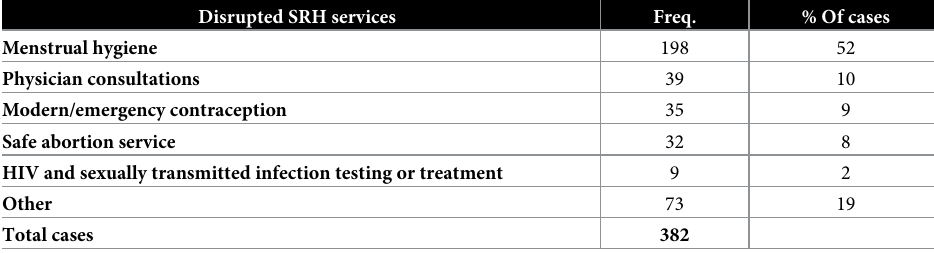
Table 4. Reported disruption in SRH